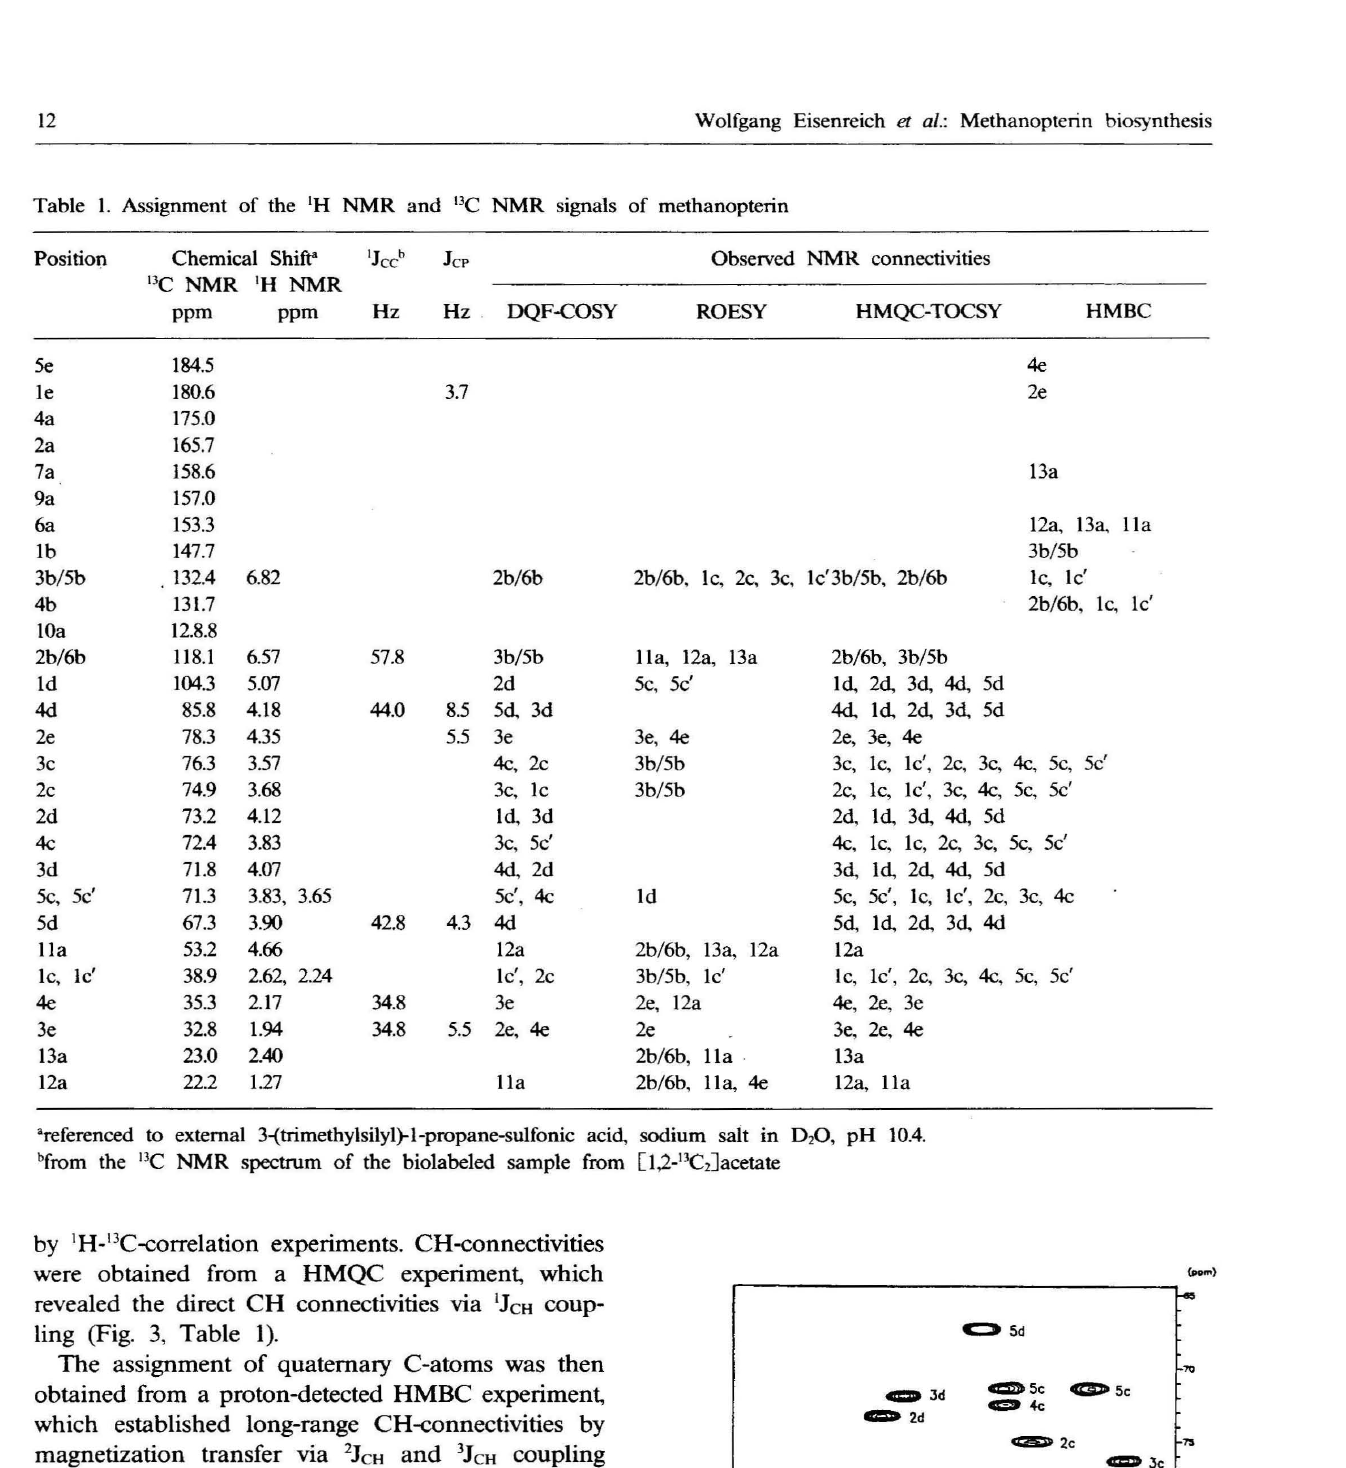
Figure 3. HMQC spectrum of methanopterin, representing the 'H-'lC correlation pattern of the ribose moiety (2d-Sd) and the ribityl moiety (2e-Se) of methanopterin,